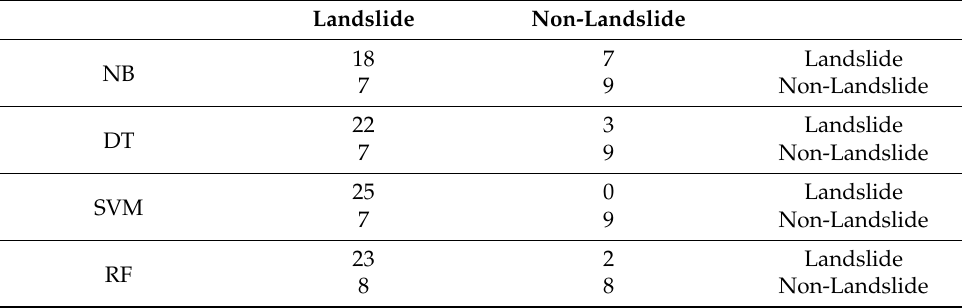
Table 6. Confusion matrix of classification results on test